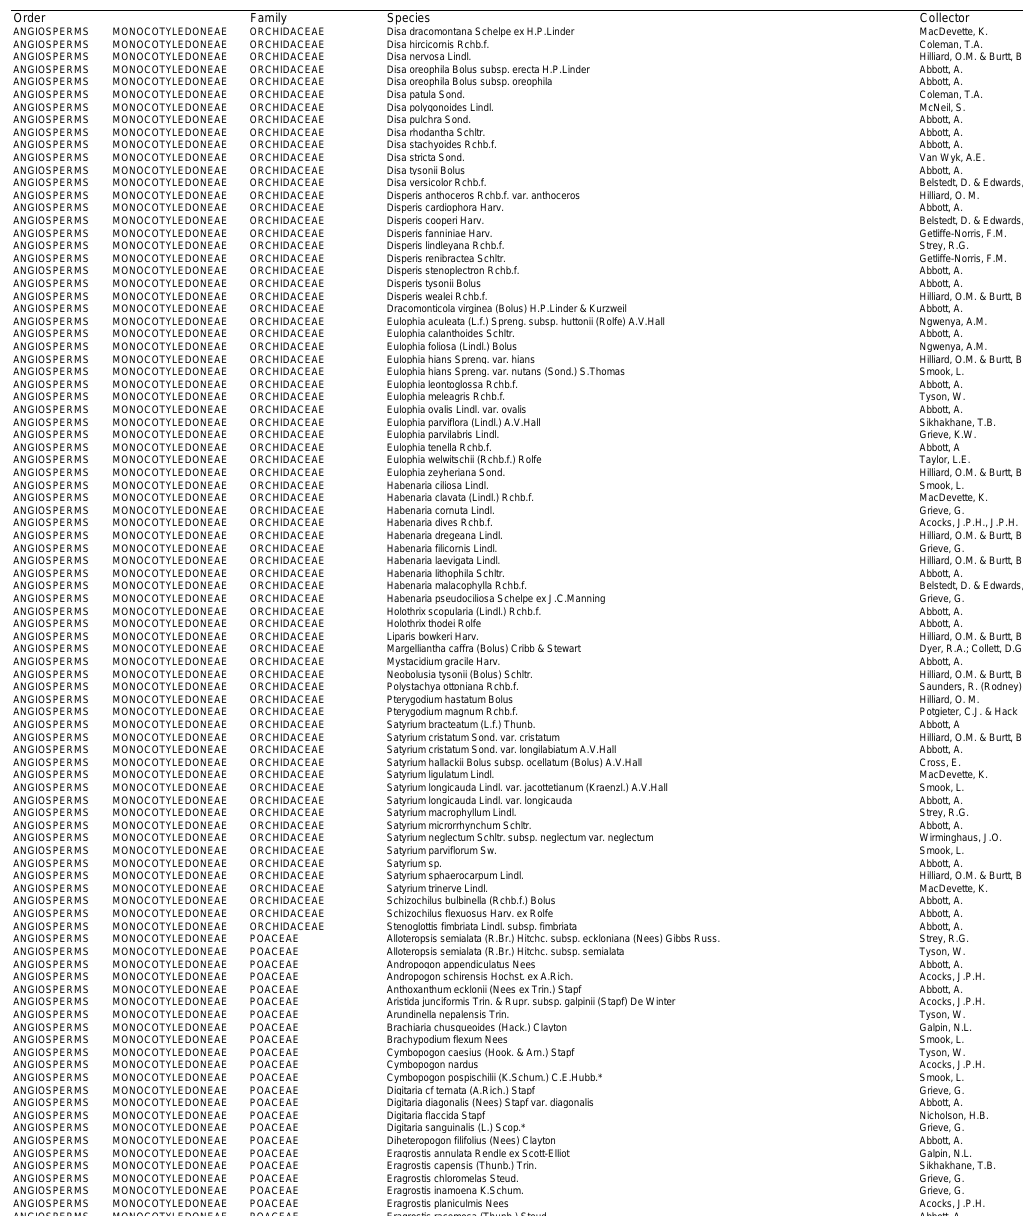
SAM LC Grassland Grass-like ANGIOSPERMS MONOCOTYLEDONEAE POACEAE Cymbopogon nardus Acocks, J.P.H. Observation LC Grassland Grass-like ANGIOSPERMS MONOCOTYLEDONEAE POACEAE Cymbopogon pospischilii (K.Schum.) C.E.Hubb.* Smook, L. 1748 NU NE Grassland Grass-like ANGIOSPERMS MONOCOTYLEDONEAE POACEAE Digitaria cf ternata (A.Rich.) Stapf Grieve, G. PCE LC Grassland Grass-like ANGIOSPERMS MONOCOTYLEDONEAE POACEAE Digitaria diagonalis (Nees) Stapf var. diagonalis Abbott, A. Grassland Grass-like ANGIOSPERMS MONOCOTYLEDONEAE POACEAE Digitaria flaccida Stapf Nicholson, H.B. Grassland Grass-like ANGIOSPERMS MONOCOTYLEDONEAE POACEAE Digitaria sanguinalis (L.) Scop.* Grassland Grass-like ANGIOSPERMS MONOCOTYLEDONEAE POACEAE Diheteropogon filifolius (Nees) Clayton Abbott, A. LC Grassland Grass-like ANGIOSPERMS MONOCOTYLEDONEAE POACEAE Eragrostis annulata Rendle ex Scott-Elliot Galpin, N.L. Grassland Grass-like ANGIOSPERMS MONOCOTYLEDONEAE POACEAE Eragrostis capensis (Thunb.) Trin. Grassland Grass-like ANGIOSPERMS MONOCOTYLEDONEAE POACEAE Eragrostis chloromelas Steud. Grassland Grass-like ANGIOSPERMS MONOCOTYLEDONEAE POACEAE Eragrostis inamoena K.Schum. Grassland Grass-like ANGIOSPERMS MONOCOTYLEDONEAE POACEAE Eragrostis planiculmis Nees Acocks, J.P.H. Observation LC Grassland Grass-like ANGIOSPERMS MONOCOTYLEDONEAE POACEAE Eragrostis racemosa (Thunb.)